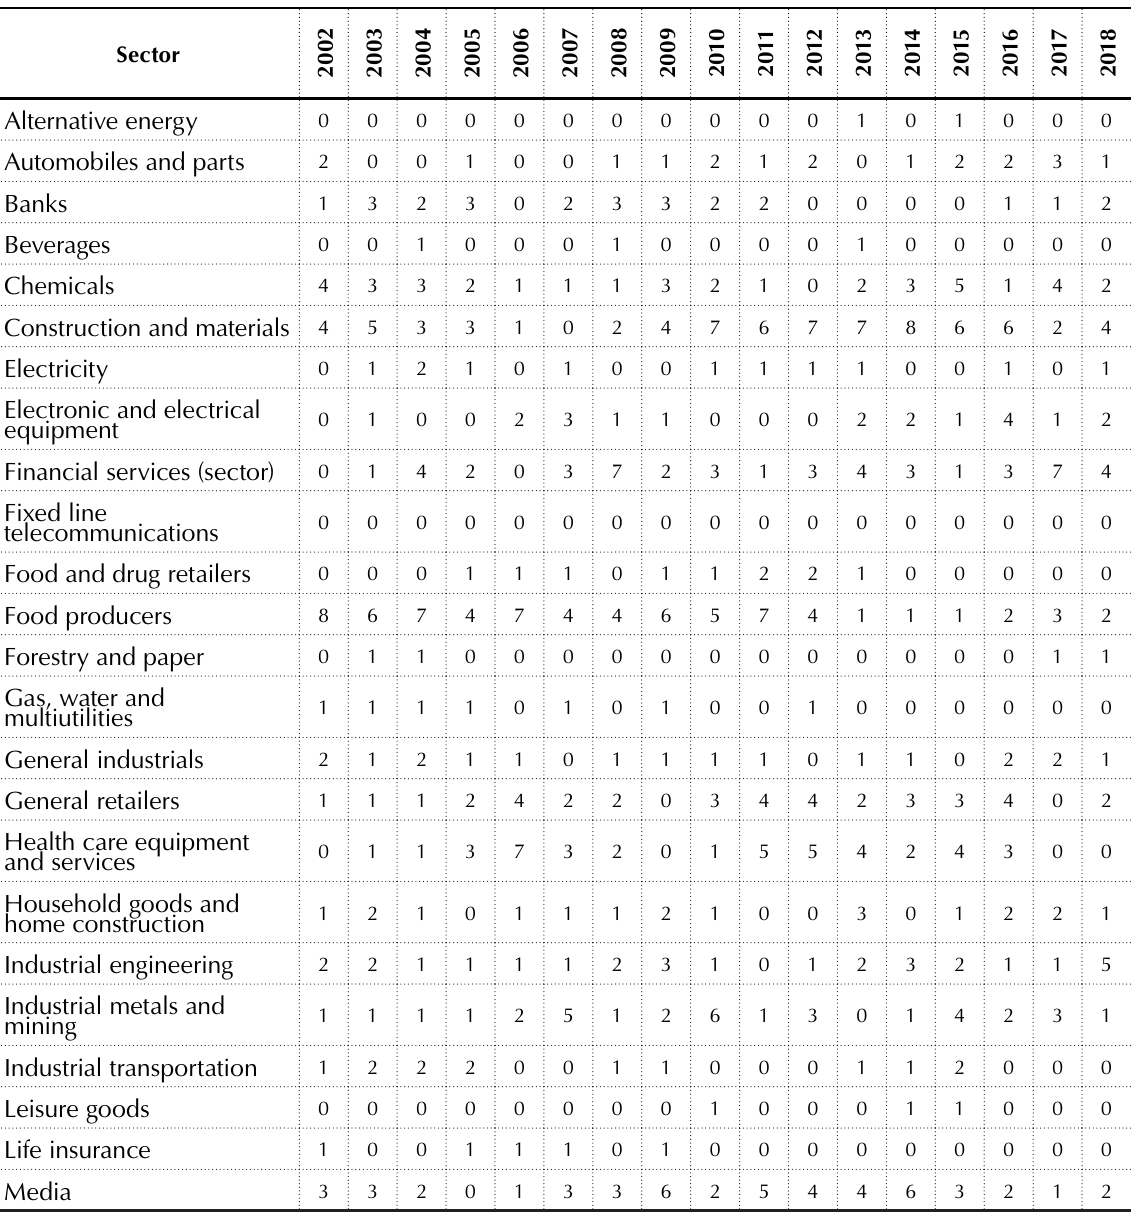
Table 9. The industrial sector of top 50 three-year growth rate of market adjusted change of MVA